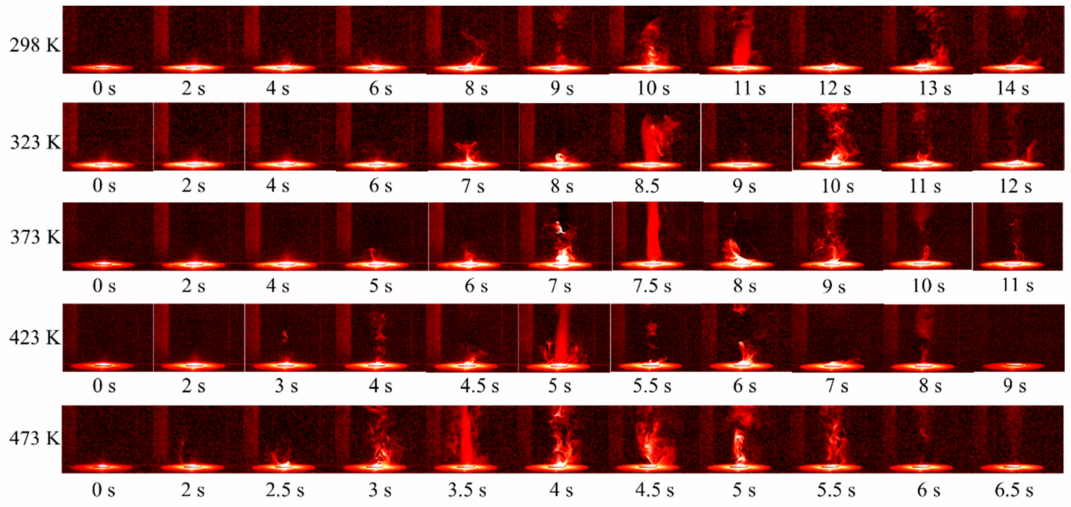
Figure 5. Ignition process of RDX at different initial temperatures.